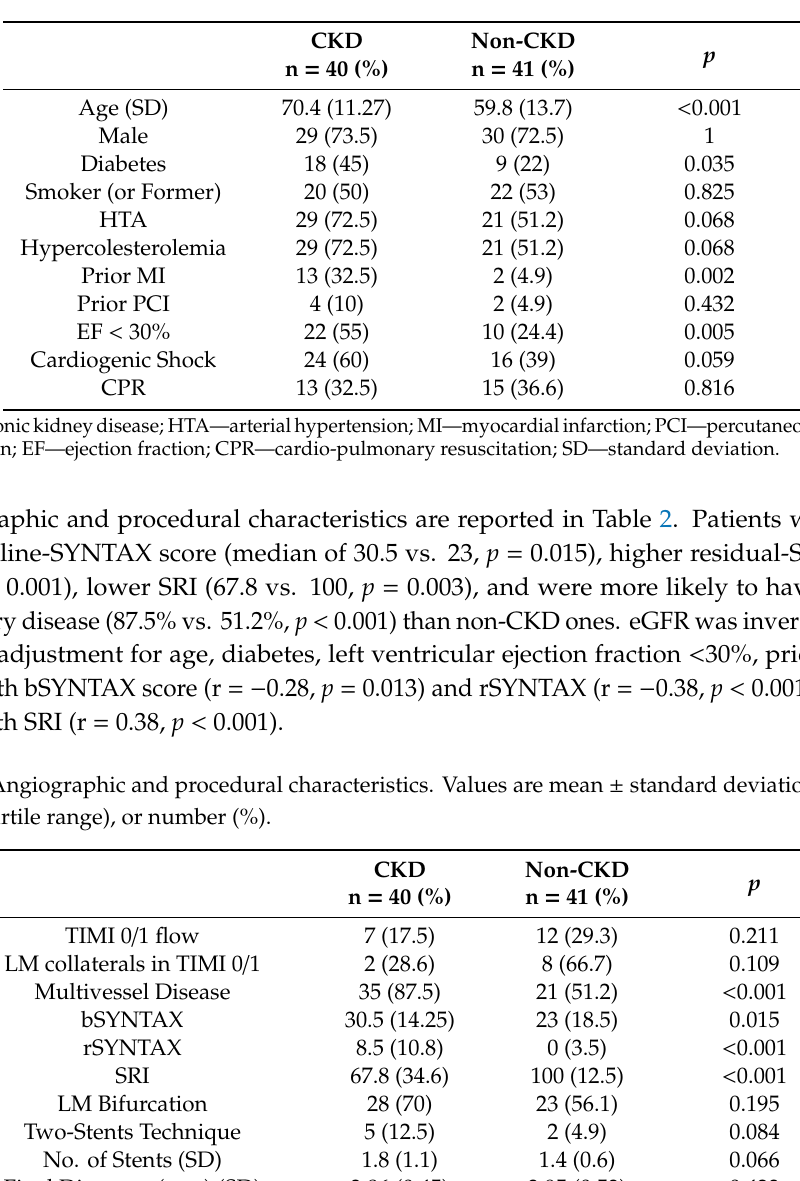
Table 1. Baseline characteristics.